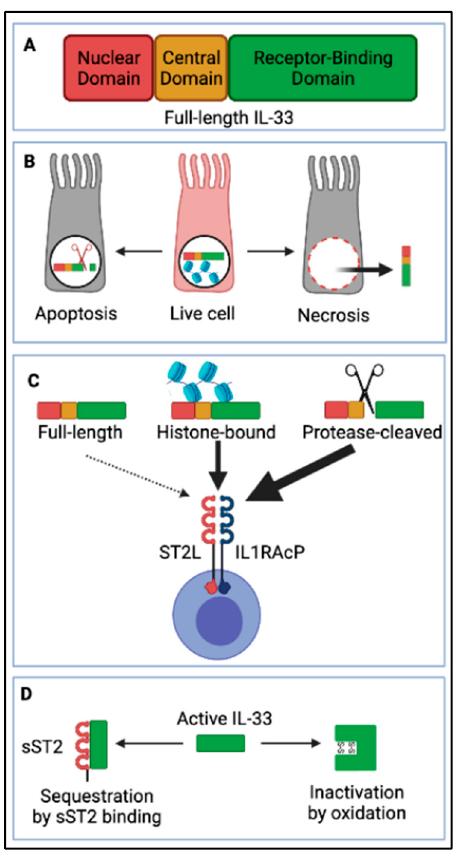
Figure 3. Interleukin-33 (IL-33) processing and release. ( A ) Full-length IL-33 consists of an N-terminal nuclear domain (ND), a protease-sensitive central domain (CD), and a C-terminal IL-1-like receptor-binding domain (RBD). ( B ) IL-33 is stored in the nuclear compartment of live airway epithelial cells, tethered to DNA. Upon cell necrosis, full-length IL-33 is released in the lung interstitium, while upon apoptosis it is cleaved in its RBD by caspases and thus inactivated. ( C ) Maturation of IL-33 is not essential for activity as full-length IL-33 is bioactive, however, proteases from mast cells, neutrophils, and allergens can cleave it in the protease-sensitive central domain, releasing shorter versions of IL-33 with even more potent activity. Additionally, full-length IL-33 can be released in complex with histones and show higher activity compared to full-length IL-33 alone. IL-33 signals through a receptor complex consisting of a transmembrane suppression of tumorigenicity 2 (ST2L) and IL1 receptor accessory protein (IL1RAcP) expressed by a variety of immune cells. ( D ) As IL-33 is a very potent alarmin cytokine, mechanisms to limit its activity are essential to avoid immunopathology. Aside from the previously mentioned ( B ) tethering of full-length IL-33 to DNA preventing its secretion in live cells, and inactivation by intracellular caspases during apoptosis, IL-33 can be sequestrated by a soluble version (decoy) of its receptor sST2 or inactivated by oxidation due to formation of disulfide bonds, which modify the protein conformation. Created with https://biorender.com/